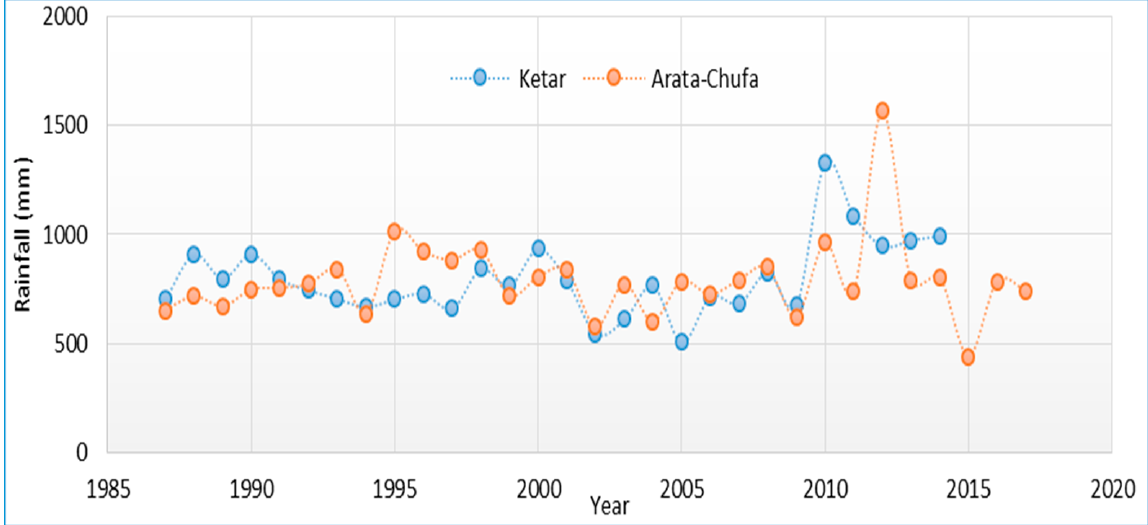
Figure 4. Mean annual rainfall for the Ketar-Genet station (7°82 ′ N and 39°029 ′ E, altitude 2314 m) and Arata station (7°83 ′ N and 39°1 ′ E, altitude 2400 m).